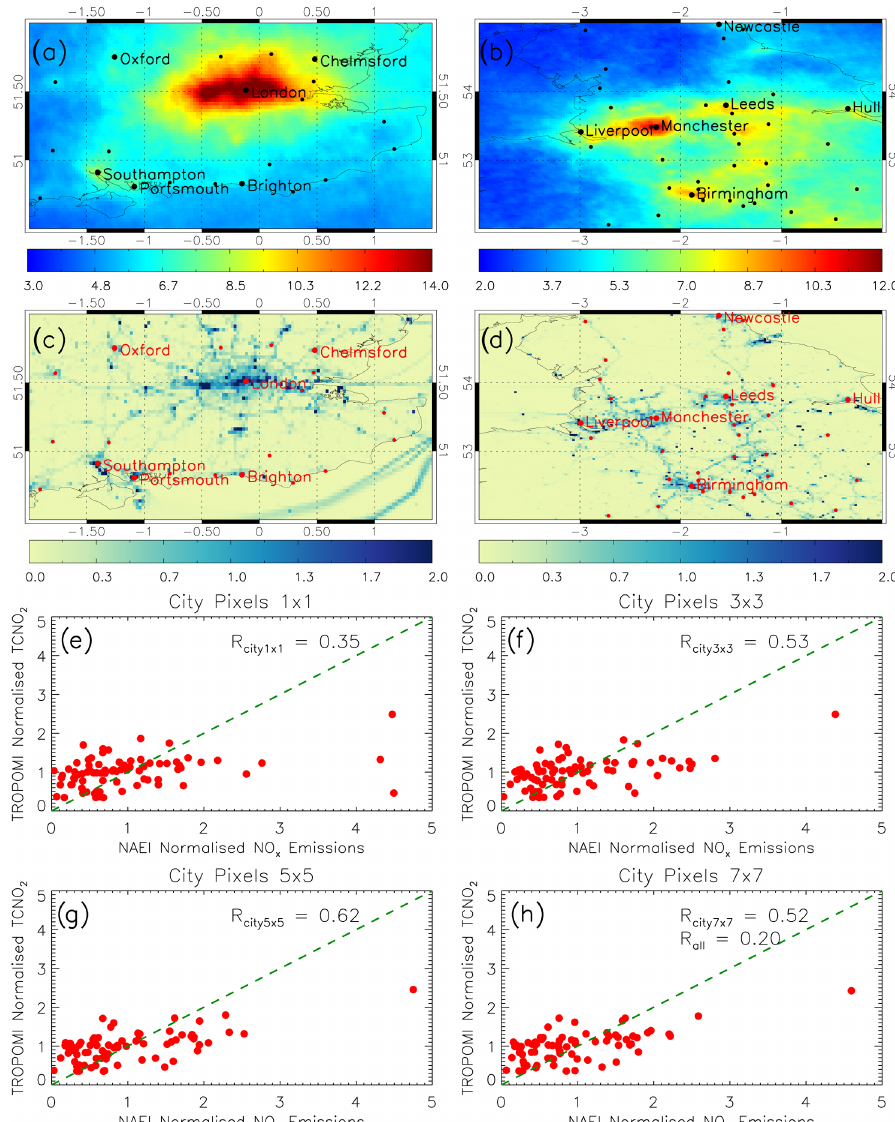
Figure 4. TROPOMI TCNO 2 ( × 10 − 5 molm − 2 ) average for February 2018 to January 2020 across (a) south-eastern and (b) northern England. Black circles represent city locations. NAEI NO x emissions (µgm − 2 s − 1 ) for 2019 across (c) south-eastern and (d) northern England. Red circles represent city locations. Panels (e) – (h) represent the correlation of normalised TCNO 2 and NO x emissions for UK cities. The green dashed line is the 1 : 1 line. Each source is normalised by the average of all the sources. The four panels also represent city means using varying pixel ranges around the source (i.e. 1 × 1, 3 × 3, 5 × 5 and 7 × 7 grid pixels). The correlations between the city-scale normalised NO x emissions and TCNO 2 are shown ( R